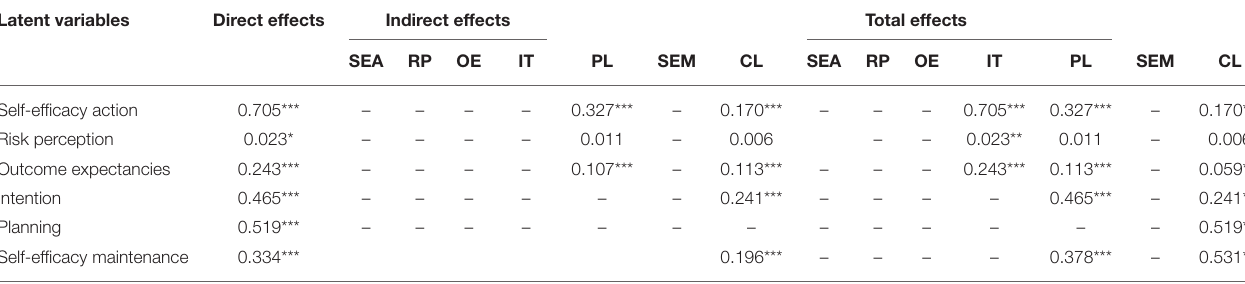
TABLE 9 | The direct, indirect and total effects of the variables in the HAPA model.